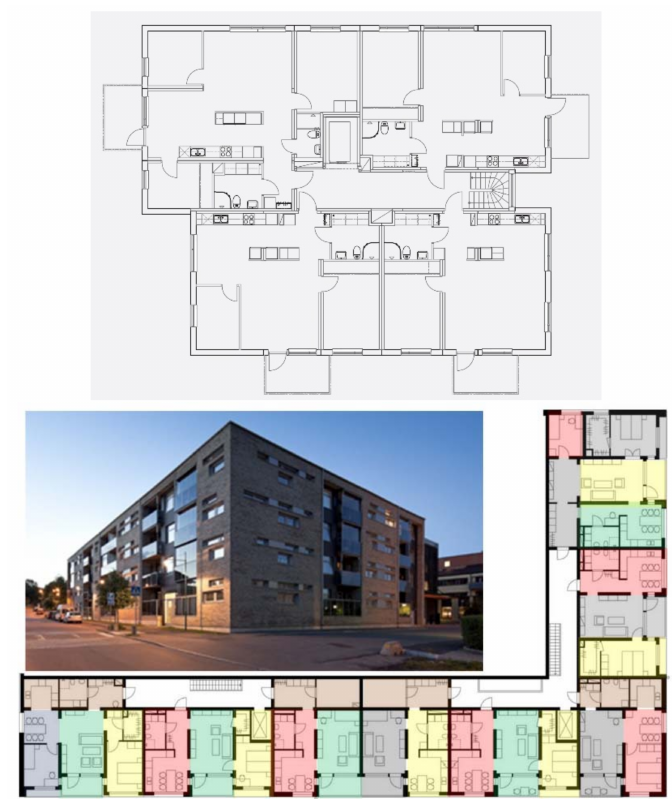
Figure 2. Layout matching to platform constraints with a volume building system (figure courtesy of Lindbäcks